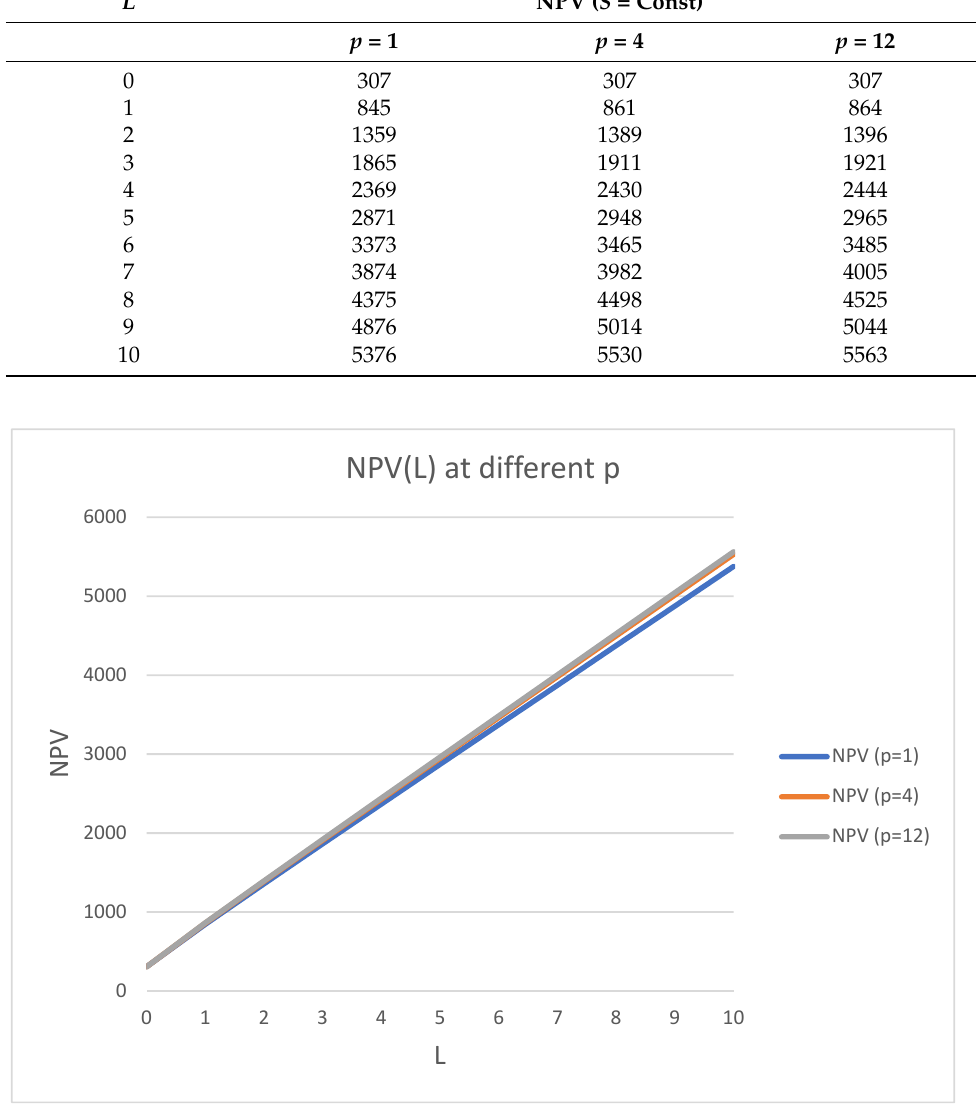
Figure 10. Change of net present value, NPV, with leverage, L , for k d = 0.14; k 0 = 0.22; p = 1, 4, and 12; and n = 3.